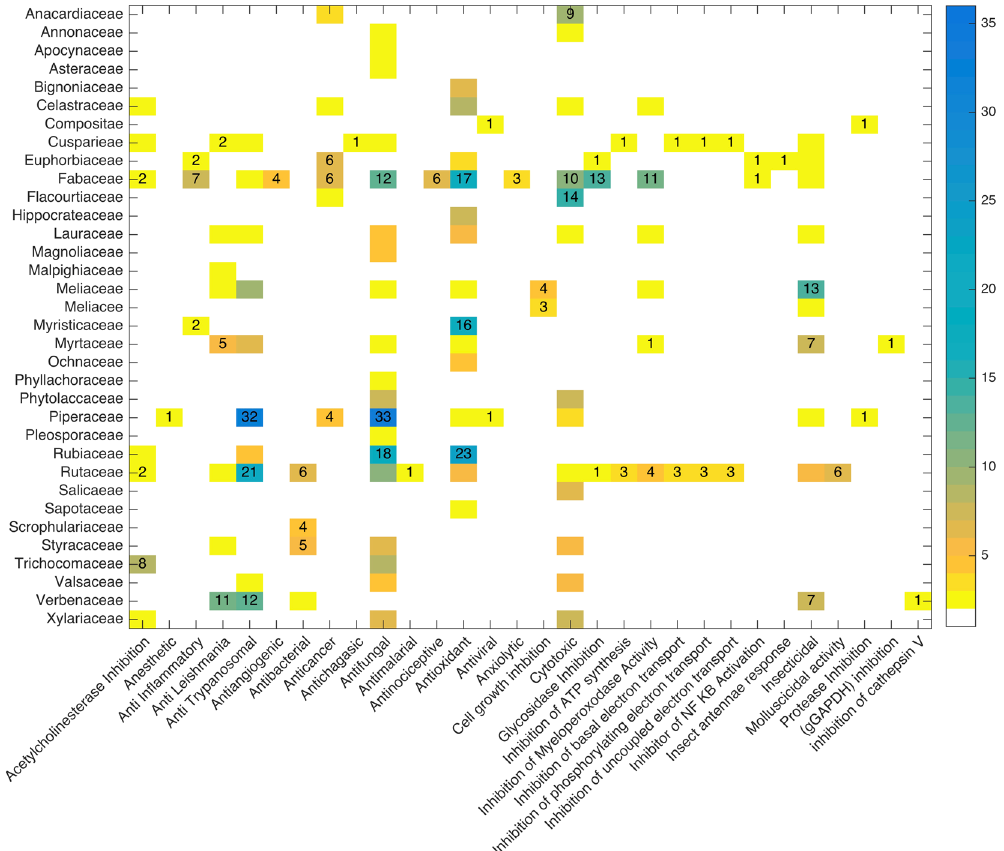
Figure 6. Heatmap of the relationships of compound biological properties with taxonomic groups